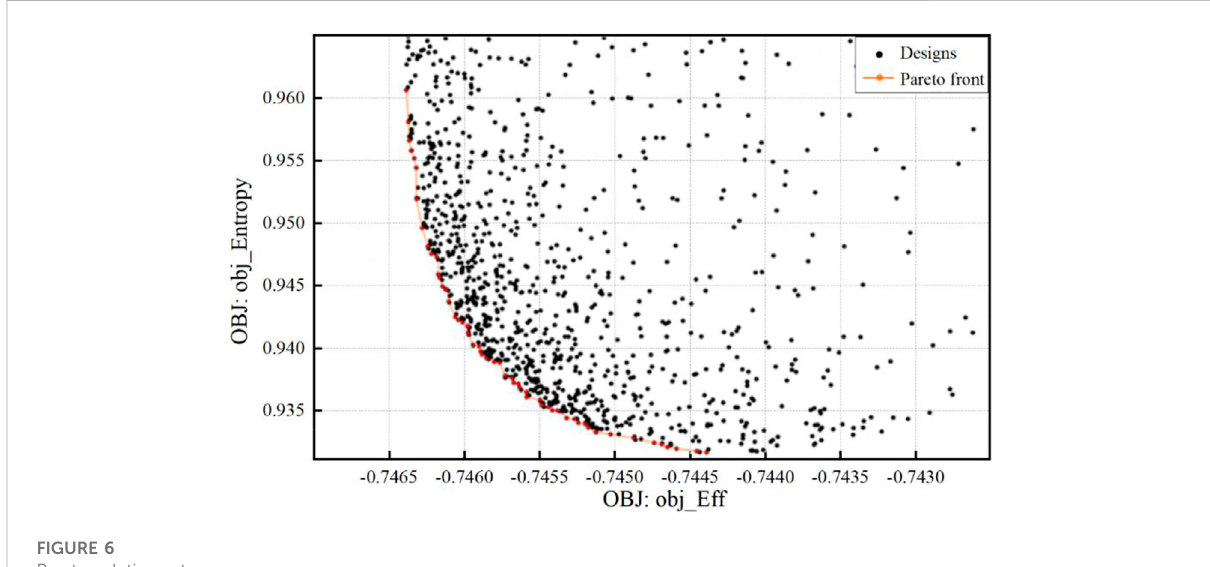
FIGURE 6 Pareto solution